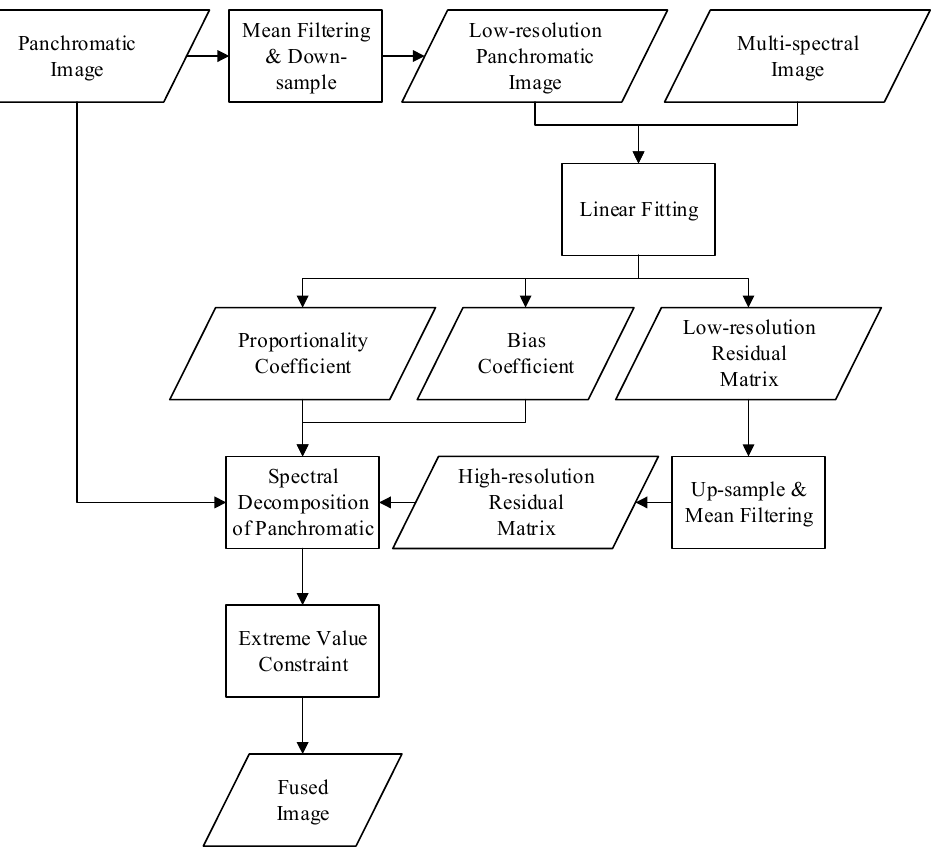
Figure 2. The flow chart of the panchromatic spectral decomposition (PSD) algorithm.